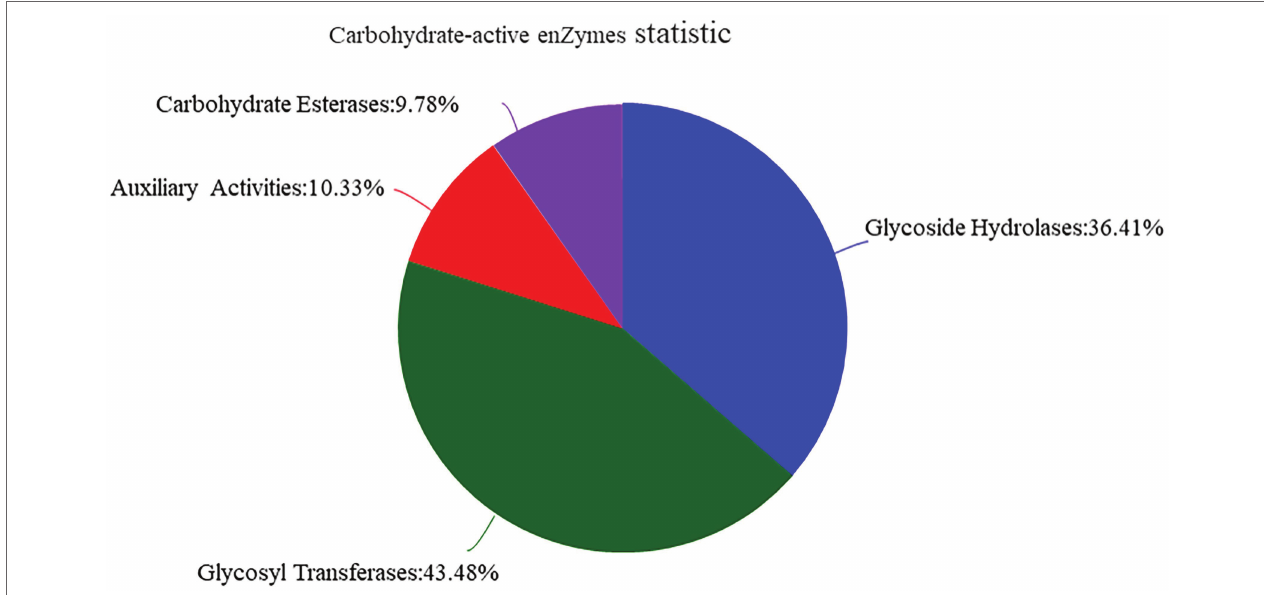
FIGURE 5 | Analysis of carbohydrate-active enzyme annotation.